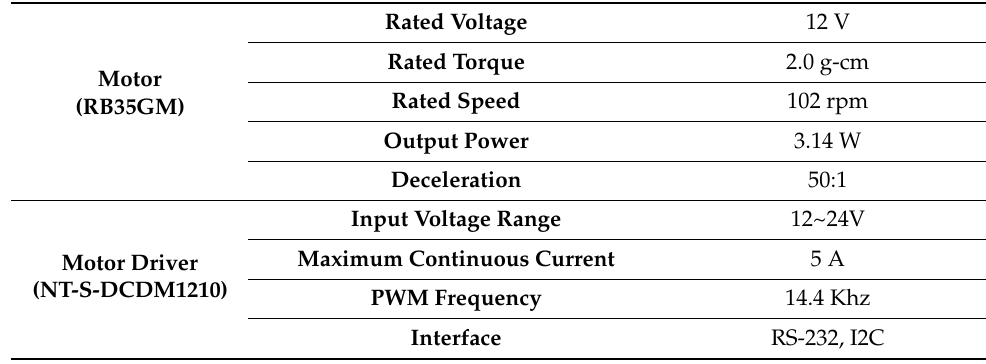
Table 3. The specifications of motor and motor driver.